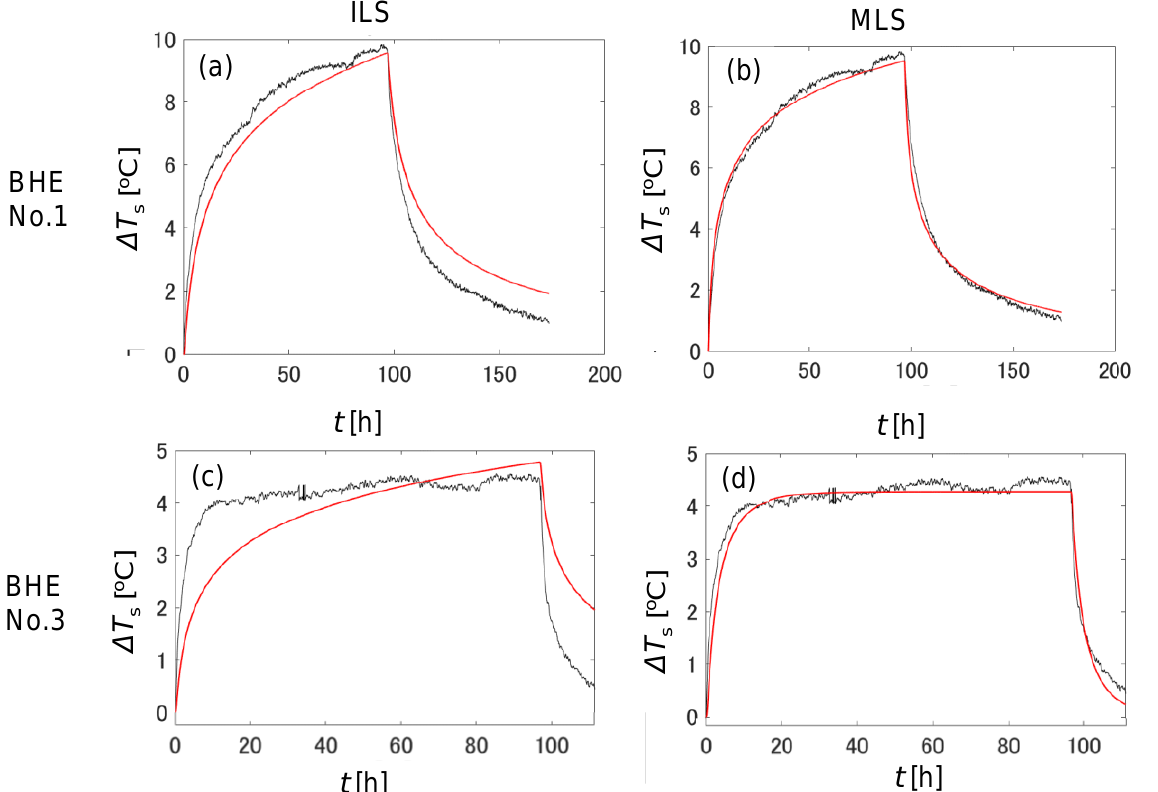
Figure 6. Example history matching results: Measured (black) and calculated (red) underground temperatures. Layer 1 in BHE No. 1 using ( a ) the ILS solution and ( b ) the MLS solution. Layer 1 in BHE No. 3 using ( c ) the Infinite Line Source (ILS) solution and ( d ) the Moving Line Source (MLS) solution.